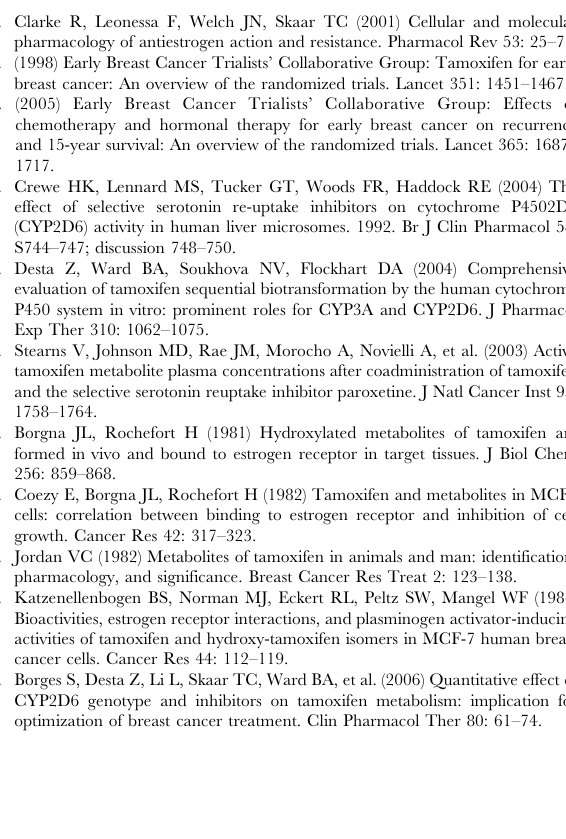
Table S6 Information on primers used in this manu-